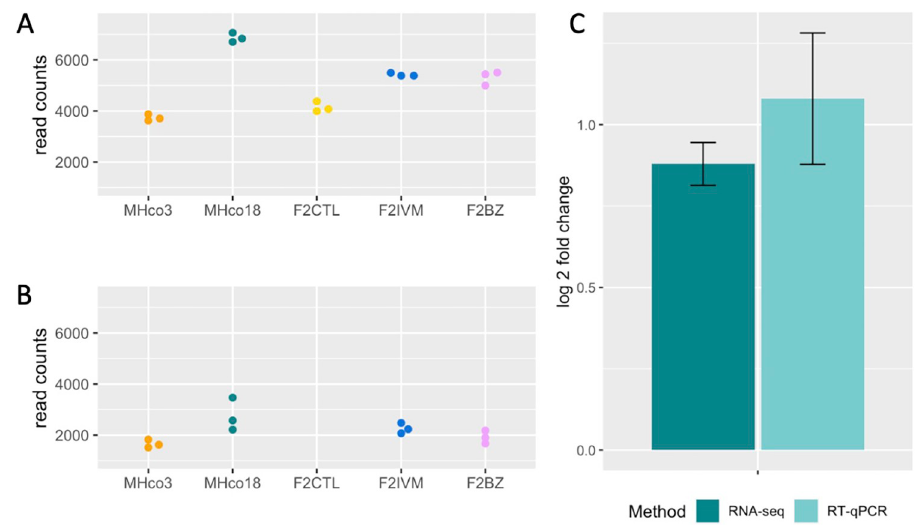
Fig 5. Expression analysis of HCON_00162780 : pgp-11 . Normalised read counts for male (A) and female (B) RNA- seq samples highlighting higher constitutive expression in all male populations relative to female populations. C. Comparison of RNA-seq and RT-qPCR data (mean of three biological replicates) for MHco18 males relative to MHco3 males, showing constitutive upregulation in the ivermectin resistant isolate. For RNA-seq data, error bars show the log fold change standard error (lfcSE) and for RT-qPCRs, error bars show the standard deviation.